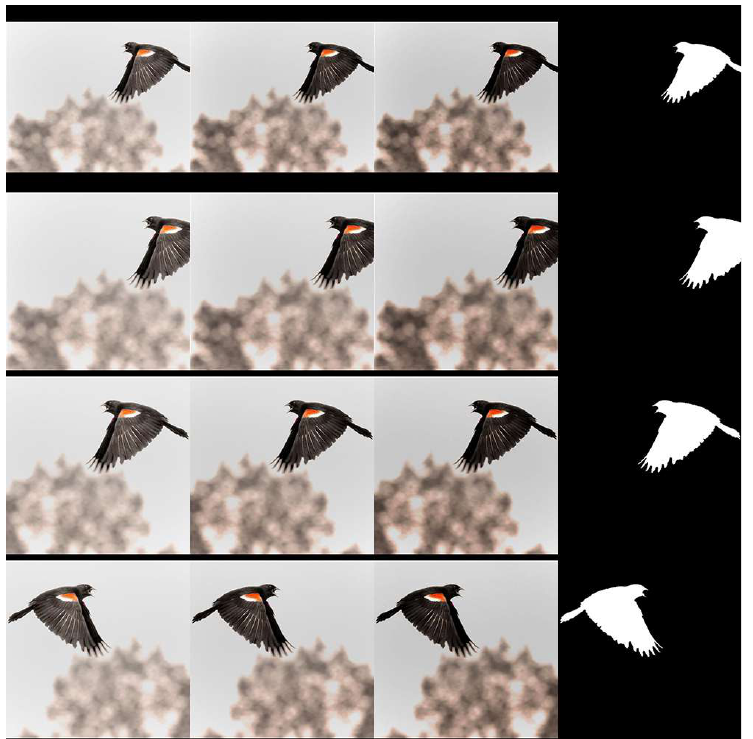
Figure 10. Examples of data augmentation. The three left columns contain the augmented versions while the last column shows the corresponding ROI ground